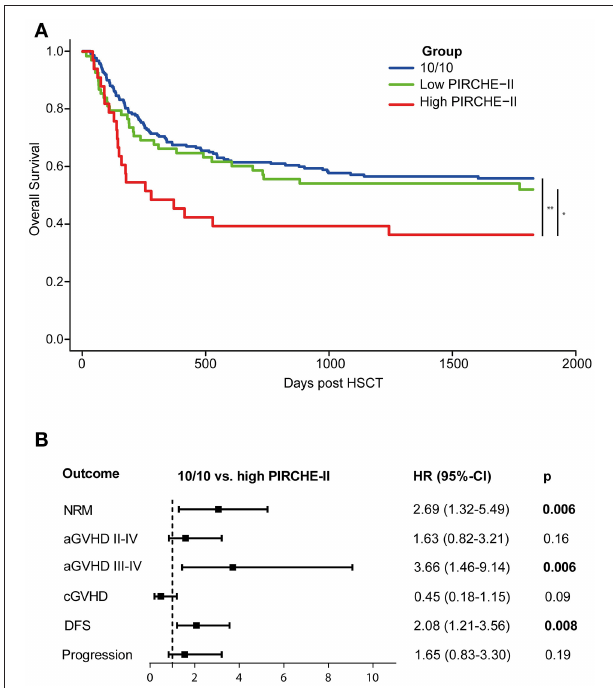
FIGURE 1 | Early-stage disease patients transplanted with a high PIRCHE-II mismatch have an impaired 5-year OS compared to early-stage disease 10/10-matched transplantations (A) and a higher risk for severe aGVHD (B) . (A) High PIRCHE-II had an impaired OS (36%) compared to the 10/10-MUD group (56%) and the low PIRCHE-II group (52%). (B) Patients with a high PIRCHE-II mismatch had a significantly increased risk of NRM and acute GVHD compared to 10/10-matched transplantations, whereas the risk for disease progression was not affected. Multivariate models included for NRM: Time to HSCT, KIR ligand status, patient CMV status, conditioning regimen intensity, patient age at transplantation, and donor age; for acute GVHD: donor age (for II-IV) and patient age (for III-IV); for chronic GVHD: aGVHD II-IV, conditioning regimen intensity, patient age at transplantation, stem cell source, and ATG; for DFS: patient age at transplantation; for progression: patient CMV status, conditioning regimen intensity, and ATG. 10/10-MUD: n = 212 patients; low PIRCHE-II group: n = 70 patients; high PIRCHE-II group: n = 33 patients. The number of outcome events in different groups: 10/10: n = 94; PIRCHE-II low: n = 34; PIRCHE-II high: n = 23. OS, overall survival; HR, hazard ratio; 95%-CI, 95%-confidence interval of hazard ratio. PIRCHE-II low,